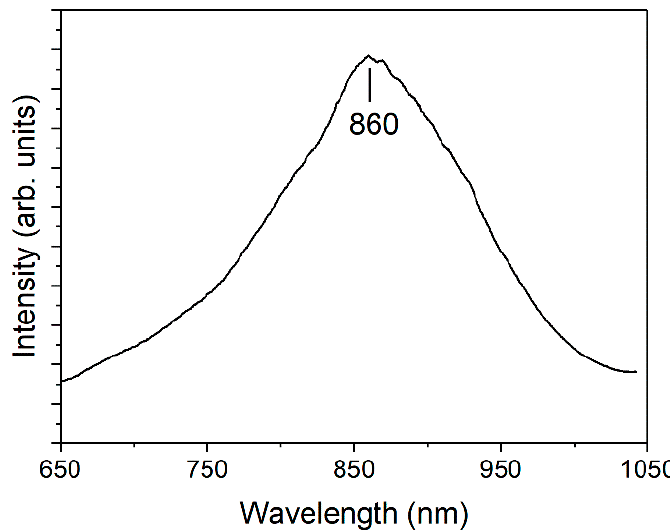
Figure 5. Photoluminescence spectrum of WSe 2 .